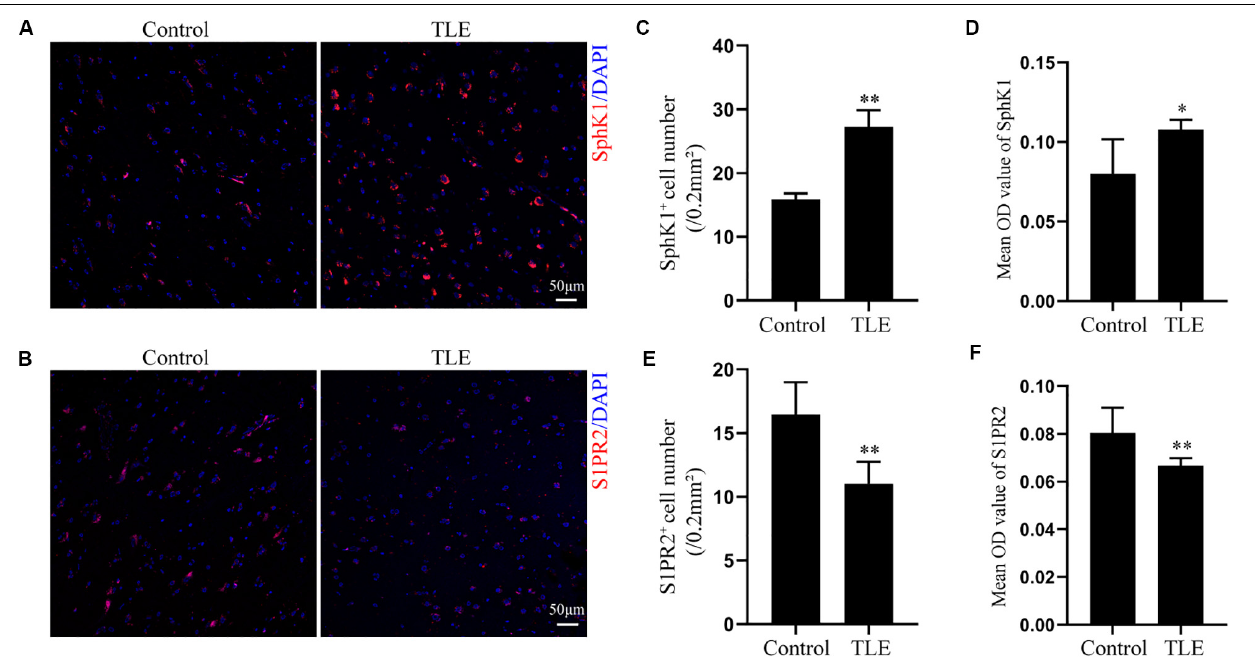
FIGURE 6 | Expression of SphK1 and S1PR2 in the drug-resistant TLE patient temporal cortex. (A) Immunofluorescence staining demonstrated the SphK1 protein levels in the temporal cortex of TLE patients. (B) Immunofluorescence staining demonstrated the S1PR2 protein levels in the temporal cortex of TLE patients. (C) The number of SphK1-positive cells in the temporal cortex. (D) Quantitative analysis of the mean OD value of SphK1-positive cells in the non-epileptic patient temporal cortex and drug-resistant TLE patient temporal cortex. (E) The number of S1PR2-positive cells in the temporal cortex. (F) Quantitative analysis of the mean OD value of S1PR2-positive cells in the non-epileptic patient temporal cortex and drug-resistant TLE patient temporal cortex. Data are presented as mean ± SD, Student’s t -test, ∗ P < 0.05, ∗∗ P < 0.01 versus the control group.